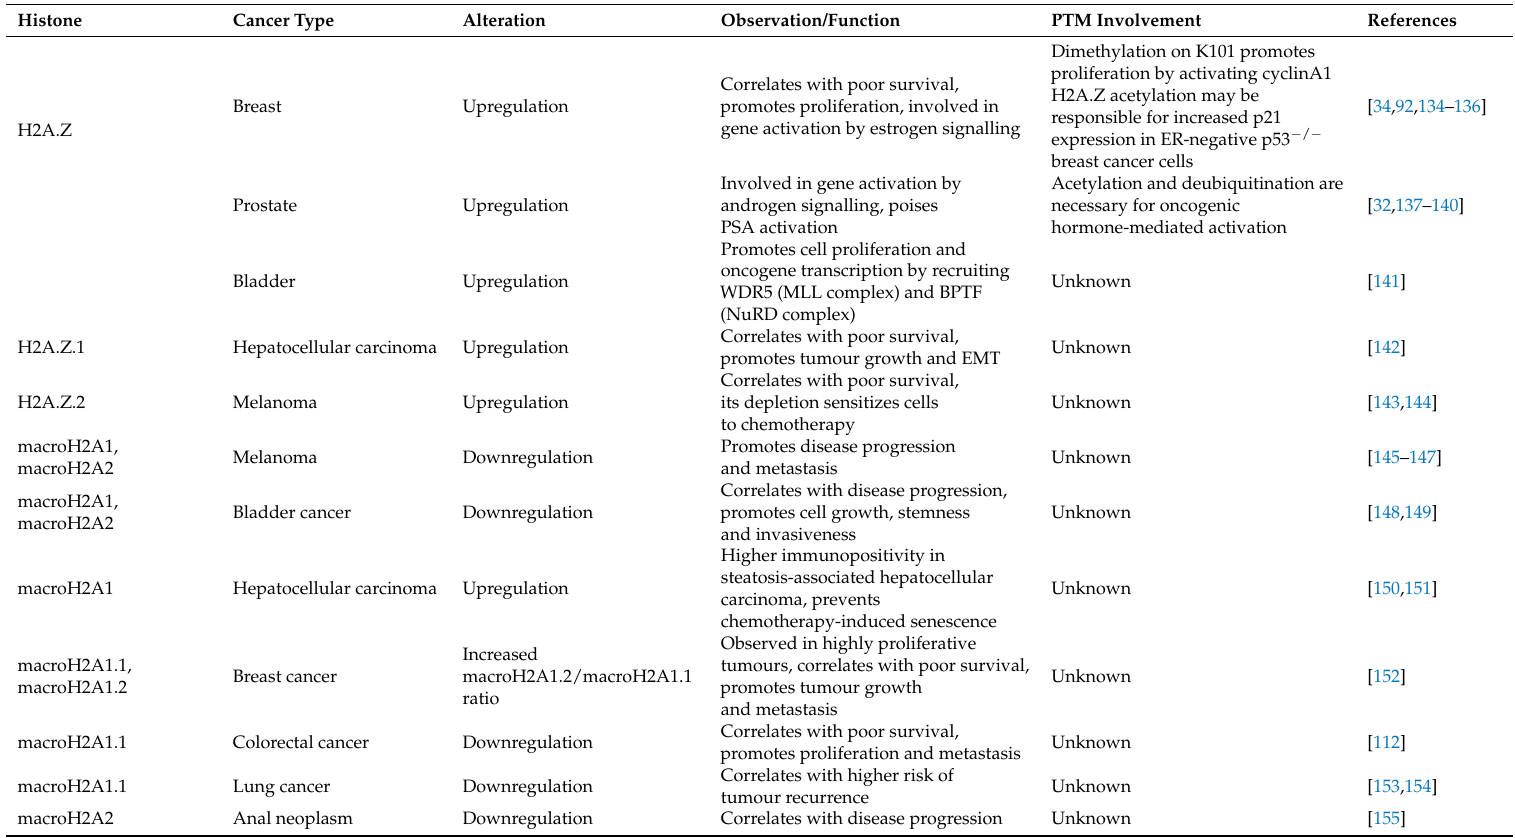
Table 2. The function of H2A variants in